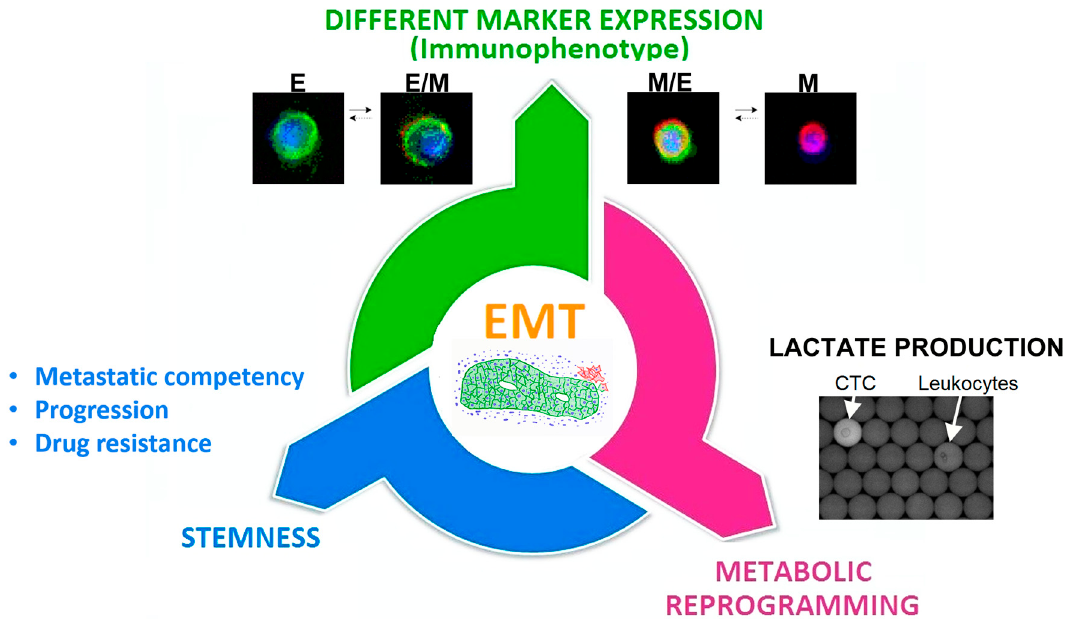
Figure 2. EMT can enhance tumor heterogeneity driving, in interested cells, phenotypic as well as functional changes increasing biological aggressiveness.